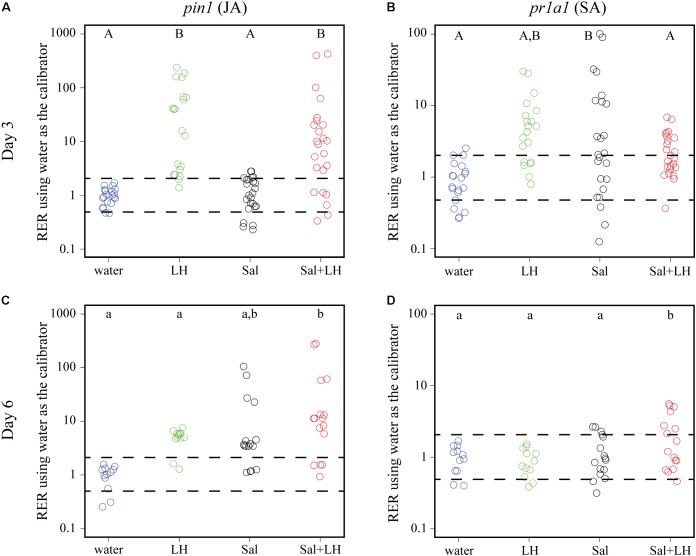
Transcription of plant defense genes changes in response to leafhoppers (LH; green circles), S. Typhimurium bacteria (Sal; black circles), or co-inoculation of bacteria with leafhoppers (Sal+LH; red circles). Plant gene expression was quantified at days 3 (A,B) and 6 (C,D) post-inoculation. Data for the JA-inducible pin1
(A,C) and SA-inducible pr1a1
(B,D) are displayed as relative expression ratios (RER) using transcription in plants treated with water (blue circles) as the negative control and calibrator. The dashed line indicates a twofold change in transcription, and each circle represents data collected from one tomato plant. Transcript levels were quantified from three biological replicates with samples taken from at least four plants per treatment per time point. Letters denote significant differences between treatments within a single time point for that specific plant defense gene (P < 0.05).